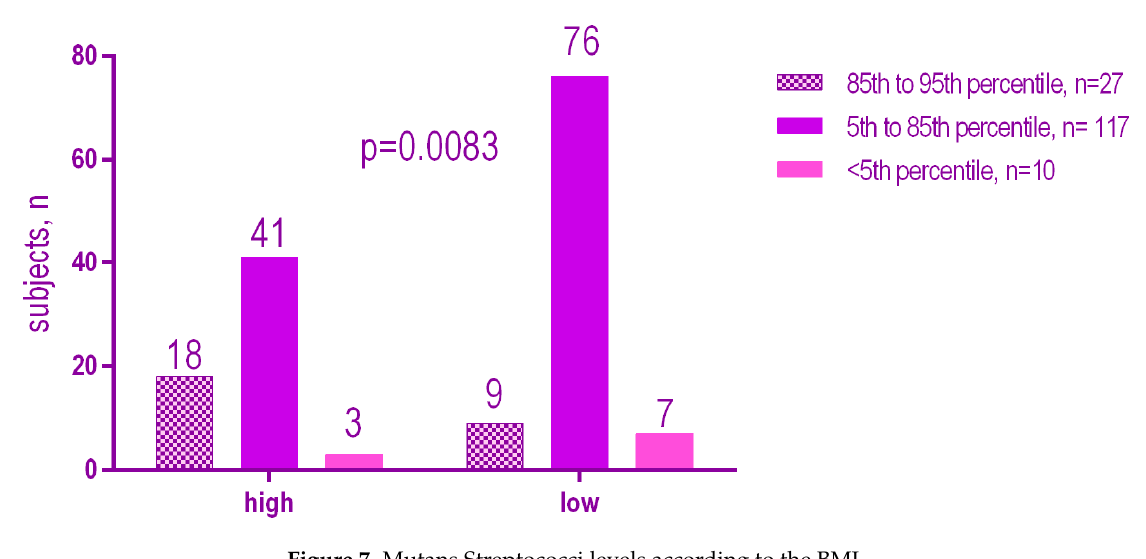
Figure 6. Relationship between the DMFT and BMI percentile.